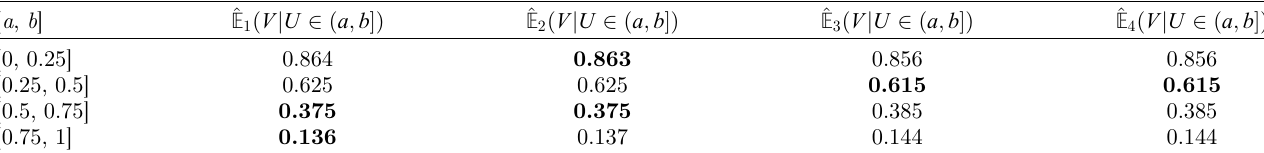
^ E Table 3. i , i = 1, 2 are computed using Frank copula, settings, i = 2, 4 from Non Informative settings. In bold the lowest values per line.